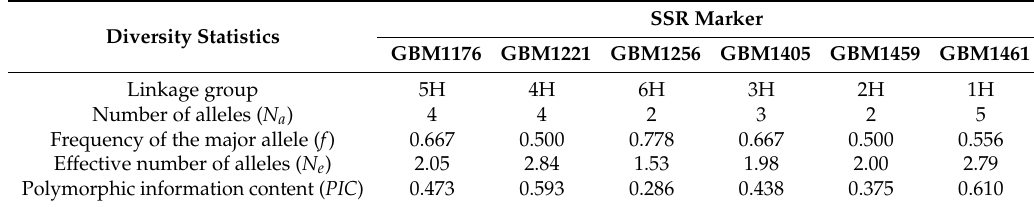
Table 1. Diversity statistics for the six genomic SSR markers [27] and genetic profiles (allele sizes) based on for the nine “Ardhaoui” barley accessions evaluated in the present